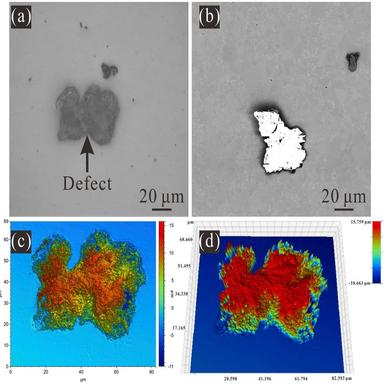
The original position HTC method for defects in TC4 titanium alloy: (a) surface profile image of a defect presented by OM in 2D characterization methods; (b) surface profile BSE image of a defect presented by HTSEM in 2D characterization methods; (c) 2D contour map of surface profile presented by WLI in 3D characterization methods for a defect, with corresponding 3D surface profile morphology as (d).